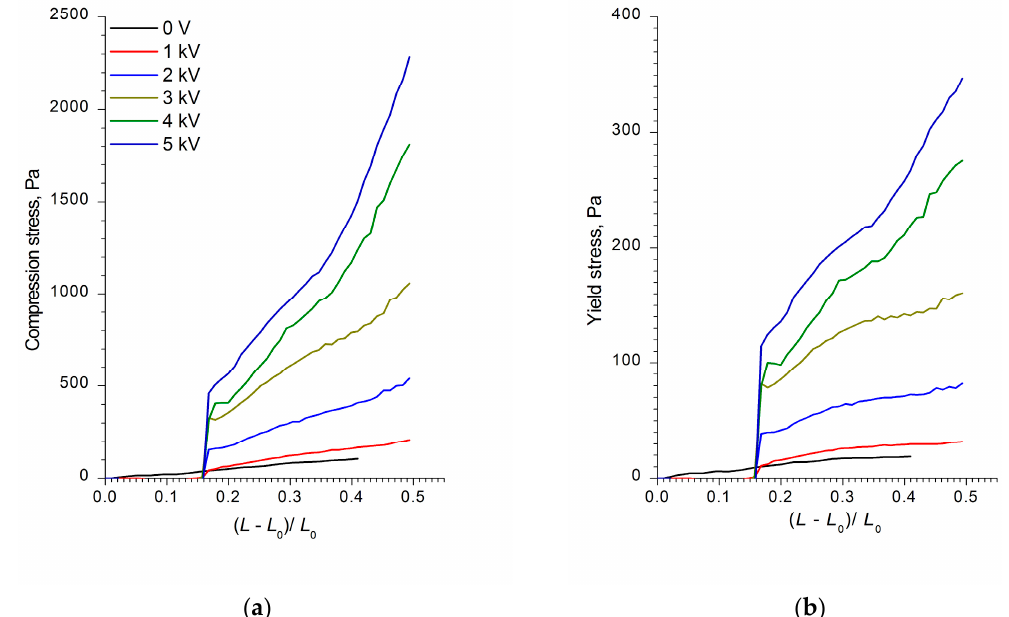
Figure 2. The dependences of ( a ) the compression stress and ( b ) the yield stress of electrorheological (ER) fluid with 60 wt% WO 3 on the deformation degree The initial gap between the electrodes was 2 mm.